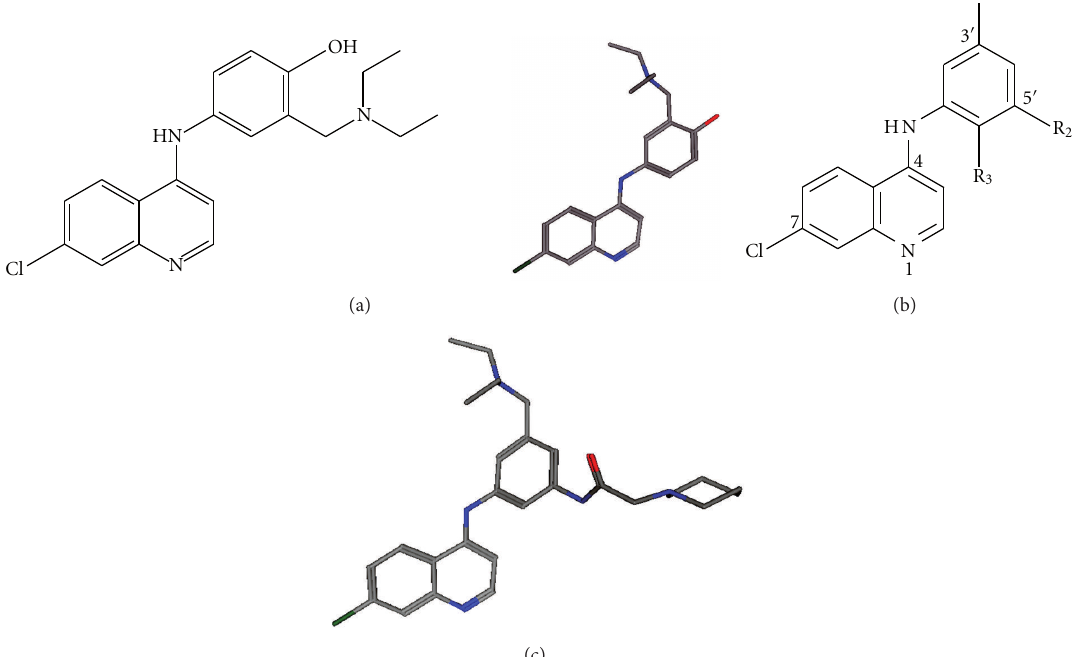
F 1: Structure of amodiaquine (a) X-ray crystal structure of amodiaquine from CCDC (626826). (b) General structure of anilinoquinolines in the database. (c) Putative bioactive conformation of compound 40 . Hydrogens are suppressed for